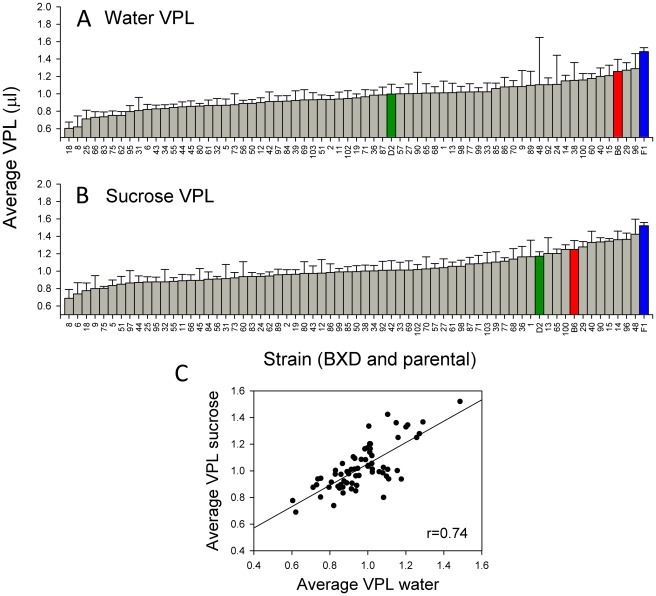
Histograms for average (± SE) volume per lick (VPL) across all BXD, parental, and F1 strains.A. Water VPL. B. Sucrose VPL. Green, blue, and red bars denote values for D2, F1 and B6, respectively. C. Scatter plot of strain averages for water MPI and sucrose MPI.